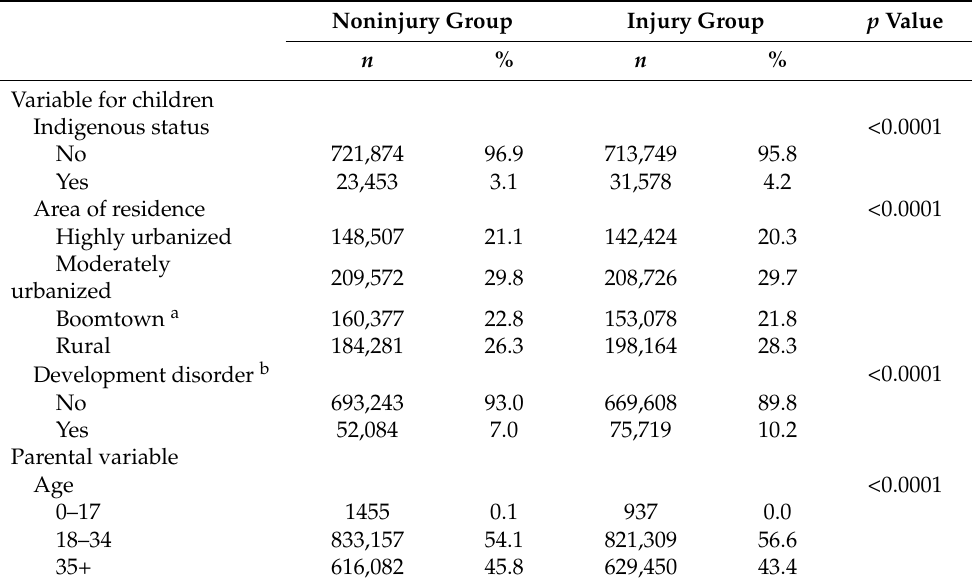
Table 1. Distribution of child injury across a set of risk